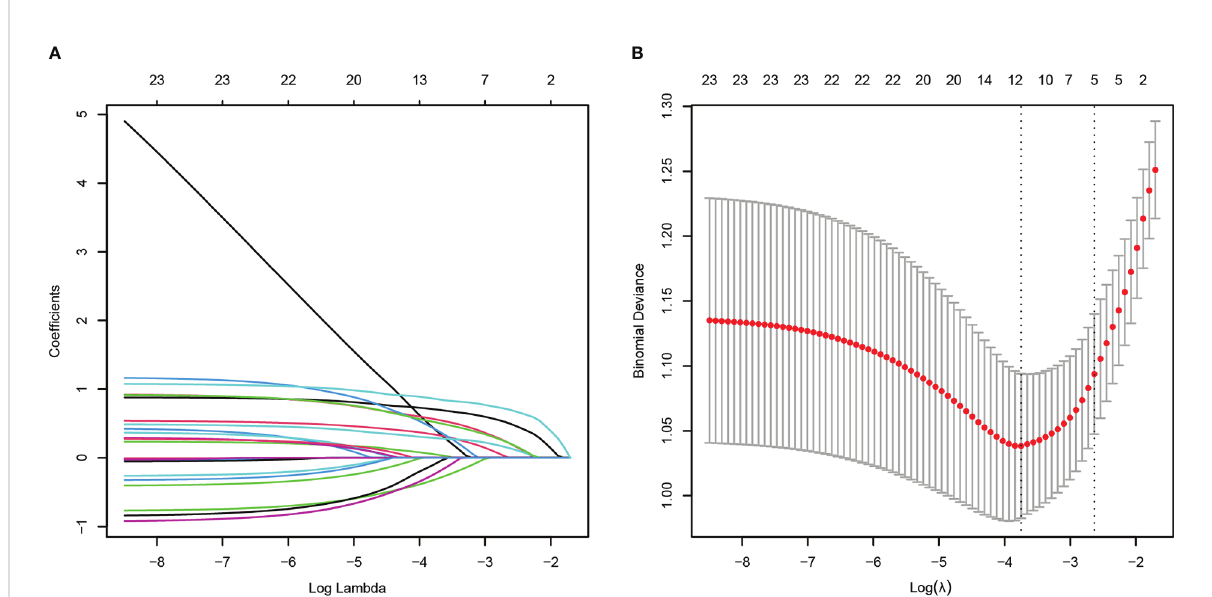
FIGURE 3 Potential risk factors selection for carbapenem resistance using the least absolute shrinkage and selection operator (LASSO) regression model with 10-fold cross validation. LASSO coef fi cient pro fi les of 23 variables (A) . A coef fi cient pro fi le plot was constructed from the log (lambda) sequence (B) . The number of characteristic variables was fi ltered by drawing dotted vertical lines at lambda.min (left dotted line) and lambda.1se (right dotted line) respectively according to the minimum criterion. LASSO, least absolute shrinkage and selection operator; SE, standard error.